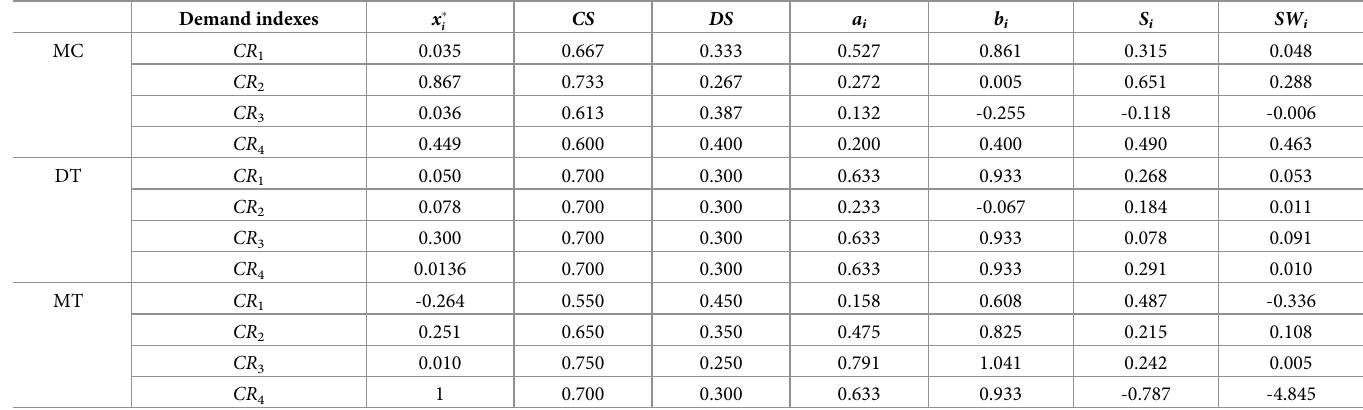
Table 7. The importance of multi-agent demands. Demand indexes